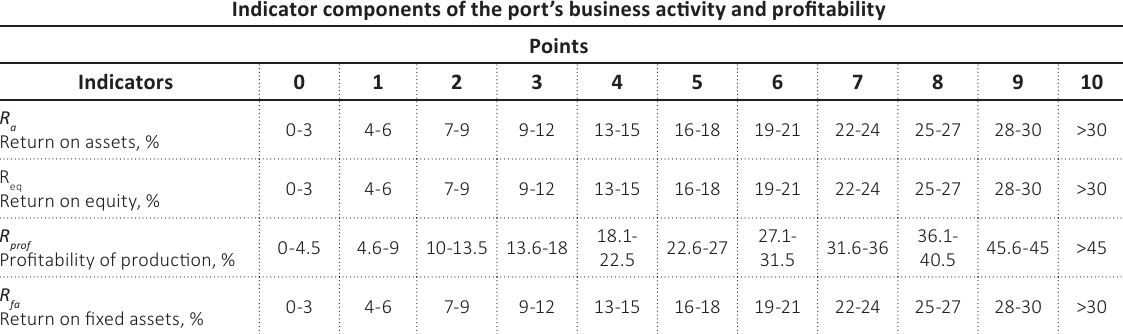
Source: Developed by the